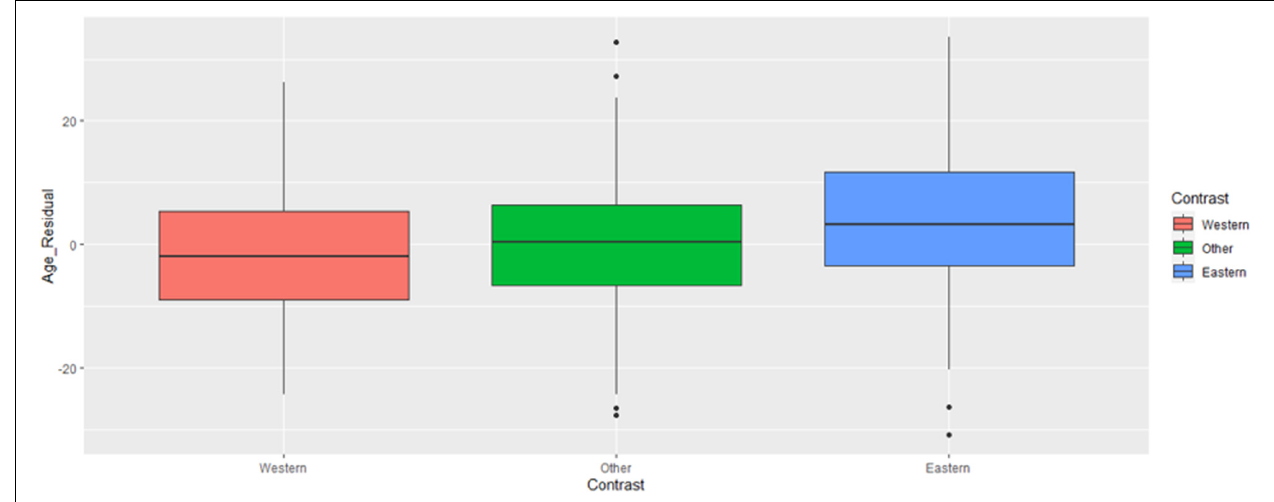
FIGURE 4 | Political leader ages by culture contrast (Study 2). Age depicted in the figure is adjusted for the presence of the economic and elderly population covariates. See SOM for figures presenting raw (i.e., unadjusted by covariate) age